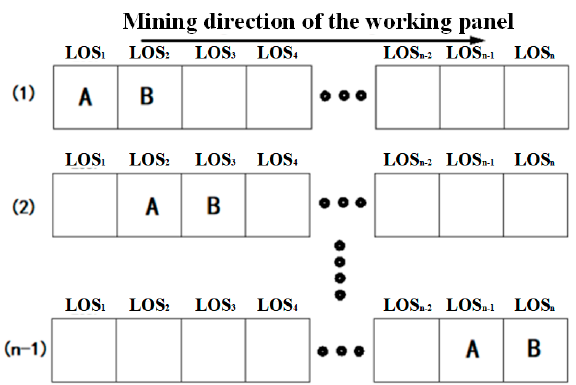
Figure 5. Flow diagram of the search for the center of the moving basin.